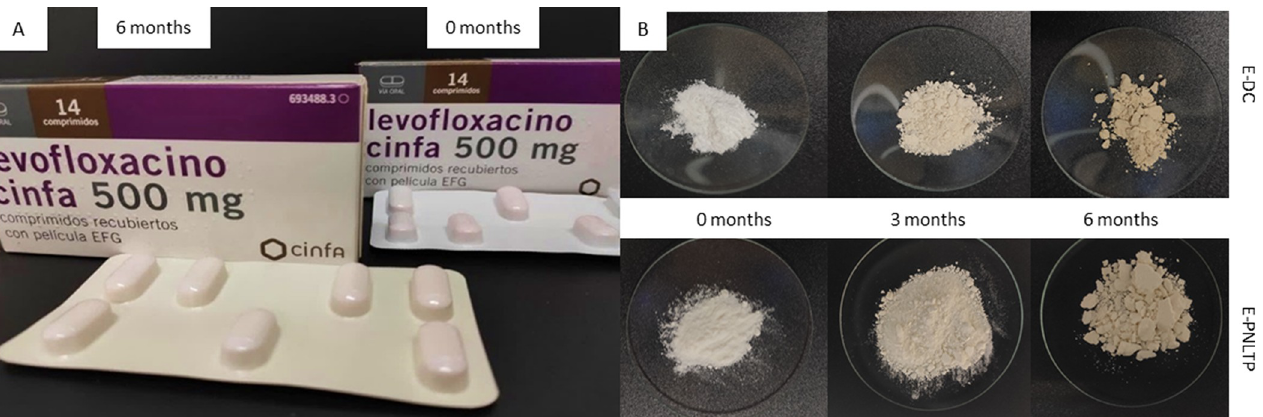
PLOS ONE | https://doi.org/10.1371/journal.pone.0282023 March 16,